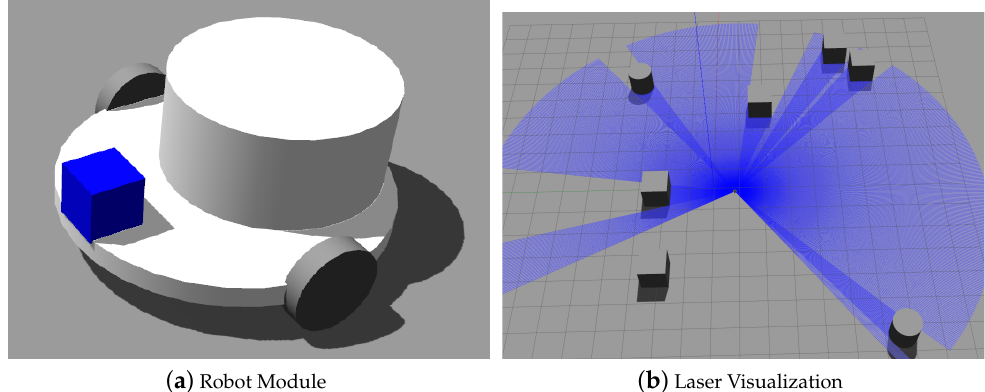
Figure 2. ( a ) the module of mobile robots in our Gazebo simulation platform; ( b ) the visualization of the